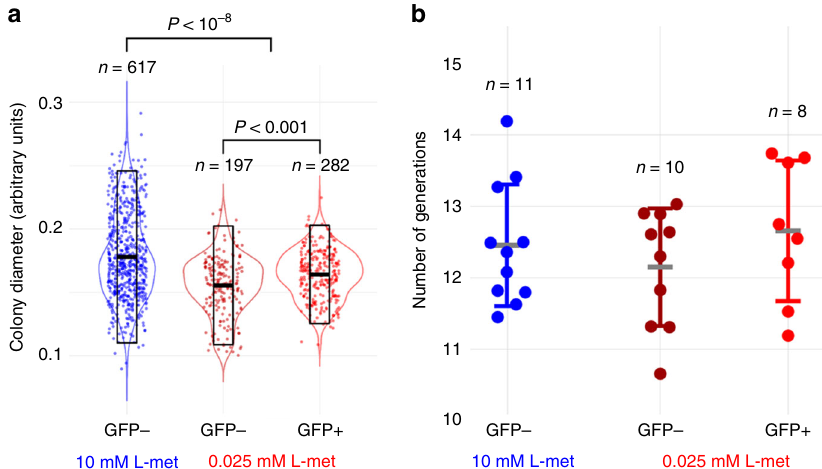
Fig. 3 The phenotypic states are inherited in long-term. a Diameter of colonies on CDM-agar plates with high (10 mM) and low (0.025 mM) methionine concentrations. At high methionine concentrations, only GFP − colonies are observed (blue). At low methionine concentrations, both GFP − (dark red) and GFP + (red) colonies are observed. Transparent boxes show mean and standard deviation. P < 10 − 8 (10 mM GFP − vs. 0.025 GFP − /GFP + ), P < 10 − 3 (0.025 mM GFP − vs. 0.025mM GFP + ). Statistically signi fi cant based on two-tailed Mann – Whitney U test. b Number of generations in colonies as determined by fl ow cytometry. Although the number of generations inferred from the fl ow cytometry data in b follow the same trend as the colony diameter data in ( a ), differences were not signi fi cant (two-tailed Mann – Whitney test). Data are presented as mean ± S.D. Error bars represent standard deviation (SD).